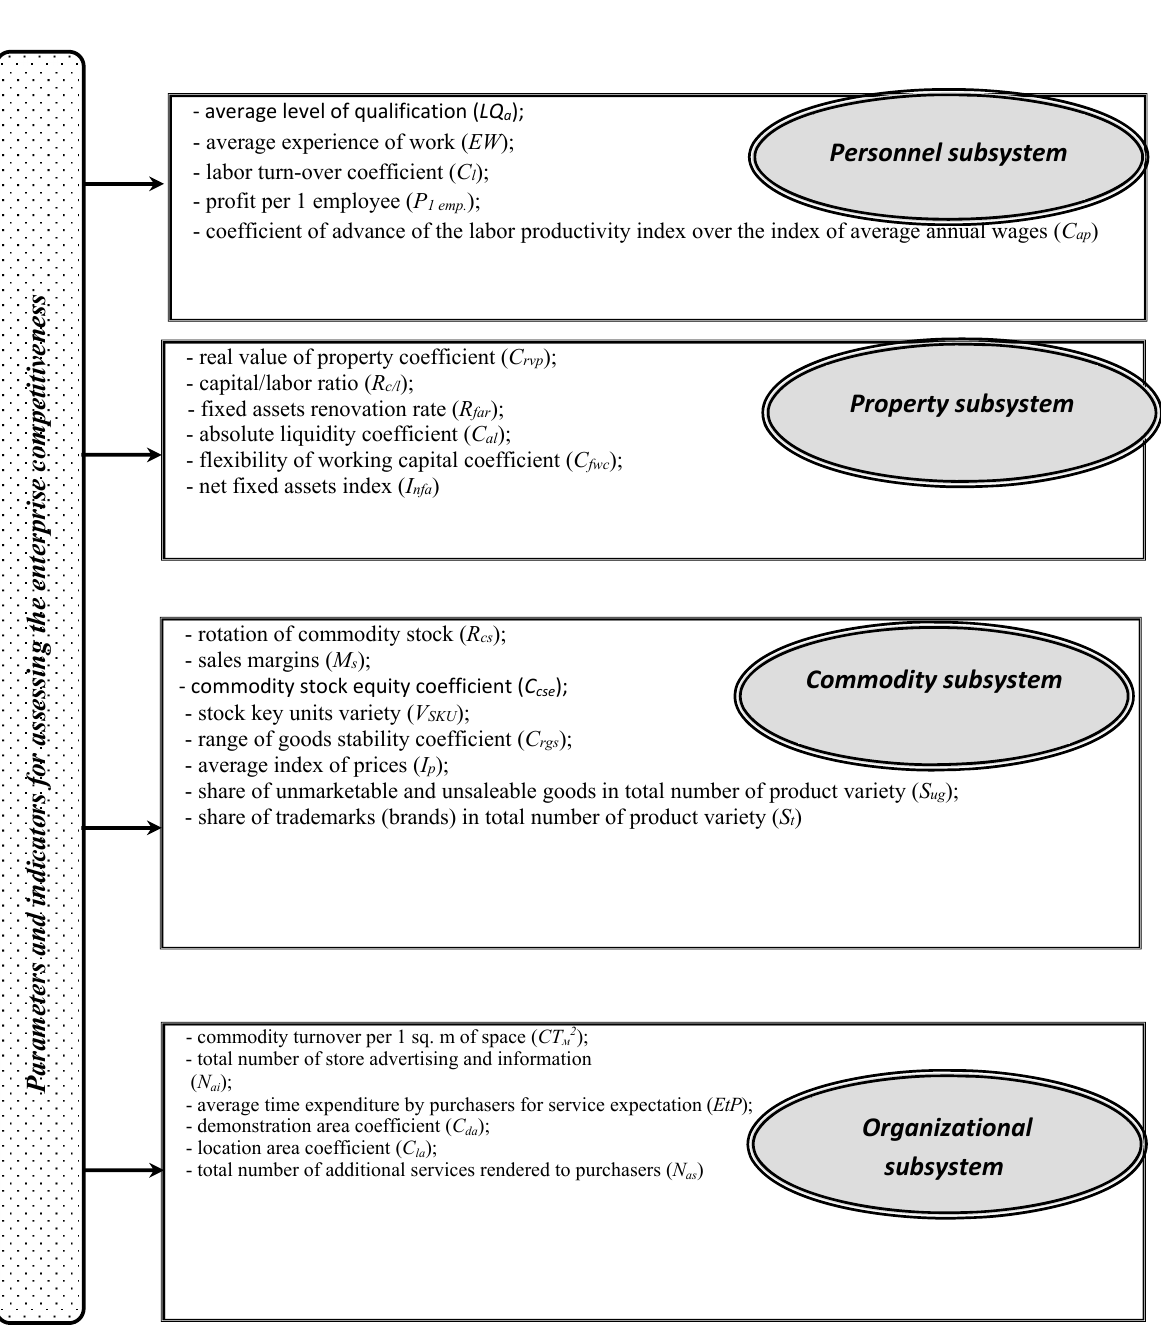
Fig. 2. Parameters and indicators for assessing the enterprise